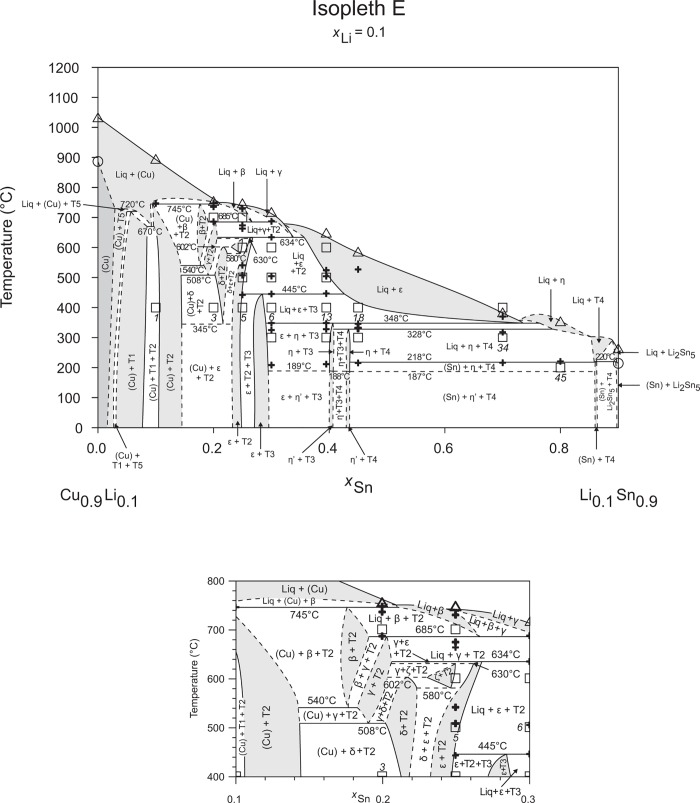
Isopleth E including section from xSn = 0.10–0.30 / T = 400–800°C.